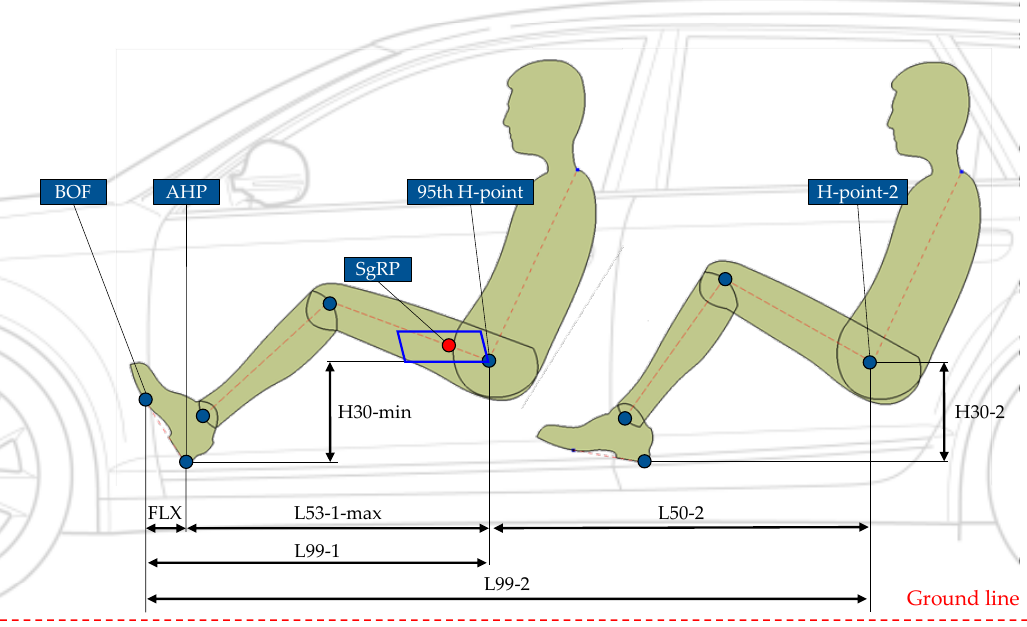
Figure 4. Overview of the dimensional chain in the X-direction [26.]